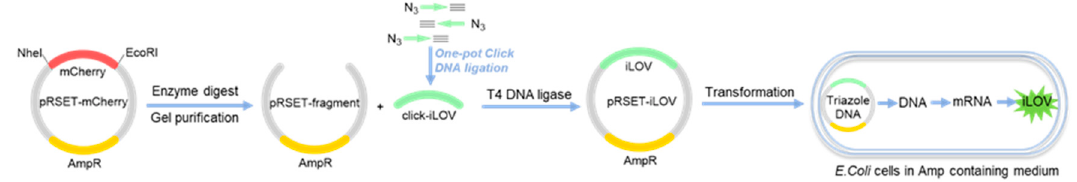
Figure 6. Transcription and translation of triazoleDNA in vivo.